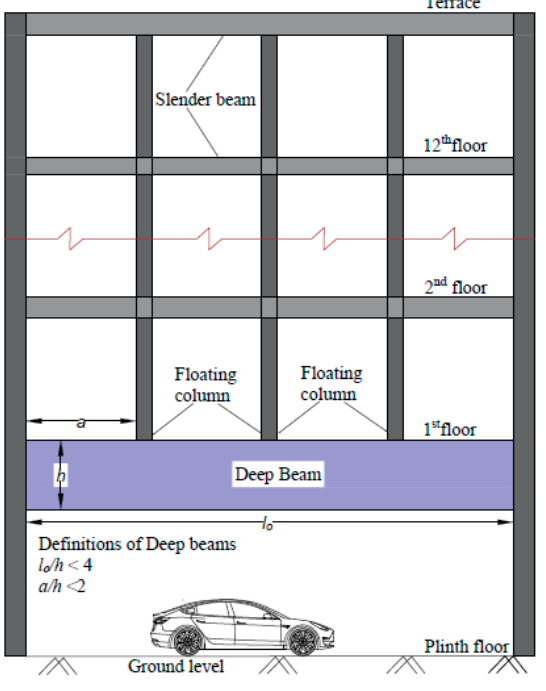
Figure 1. Deep beam in building with multiple floating columns.